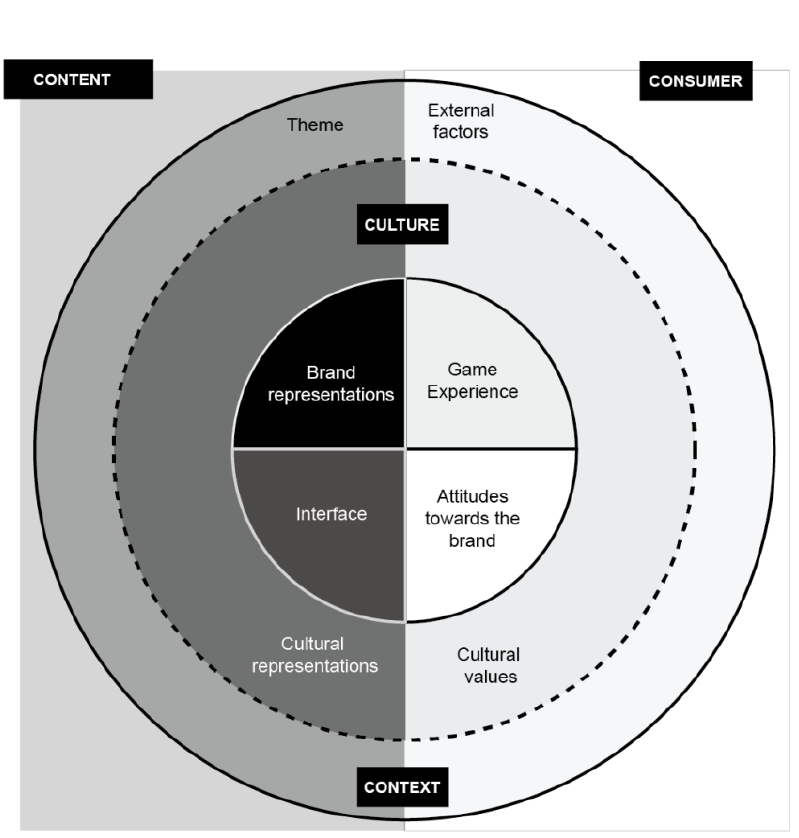
Figure 1 The framework for advergame design across cultures